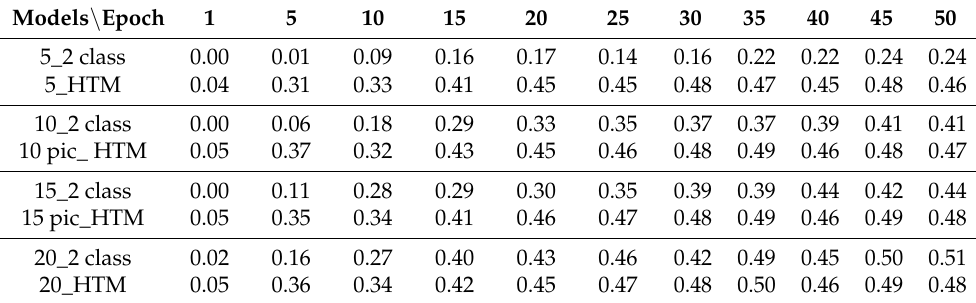
Table 3. The mAP 50 between R2 and R3 at all levels of training. Models \